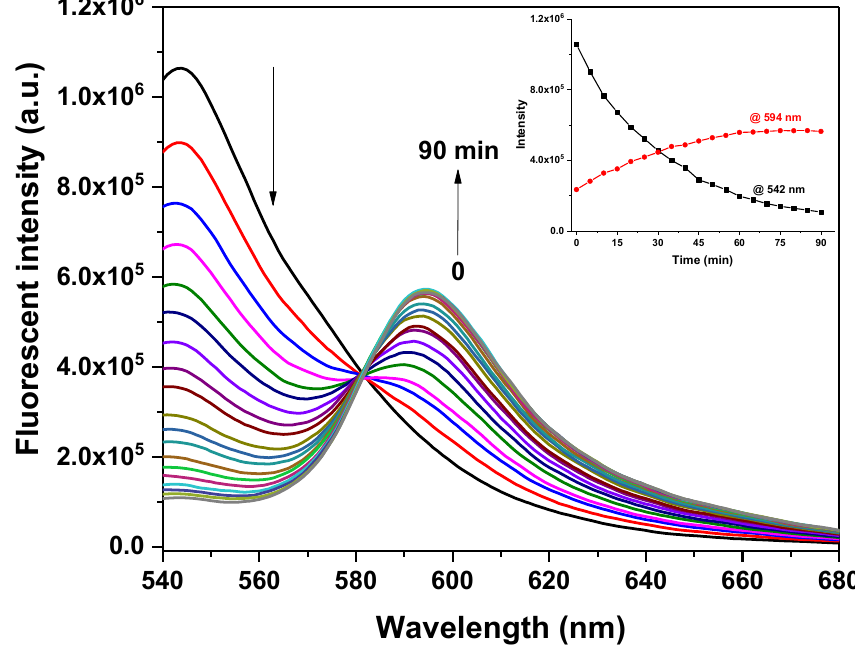
Figure 2. Time-dependent fluorescence specturm changes of probe BH (5 μM) toward H 2 S (500 μM) in aqueous solution of DMSO/PBS ( v / v 1/1, pH 7.4); inset: fluorescence intensity at 594 nm and 542 nm as a function of detection time.